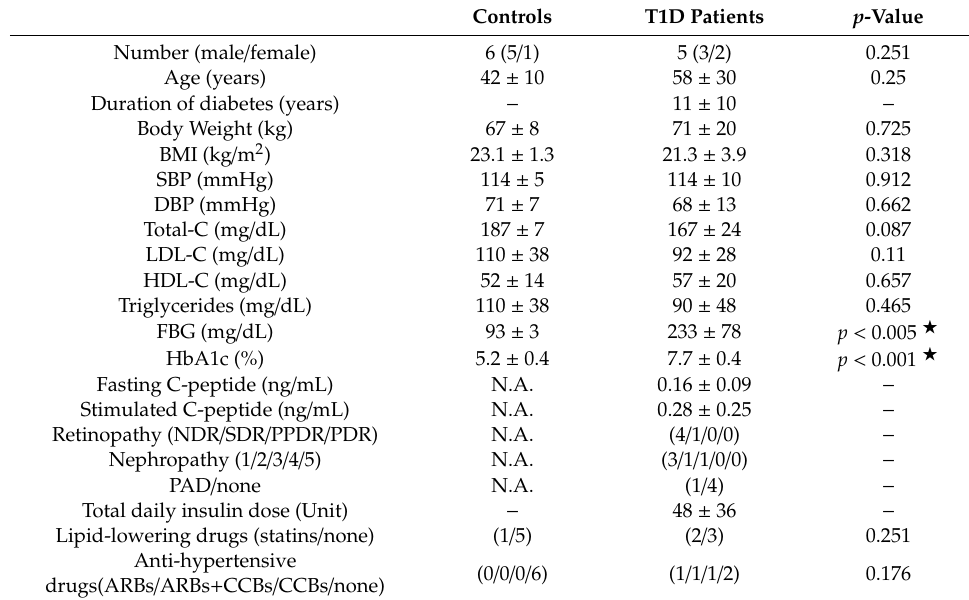
Table 2. Clinical parameters of type 1 diabetes patients and